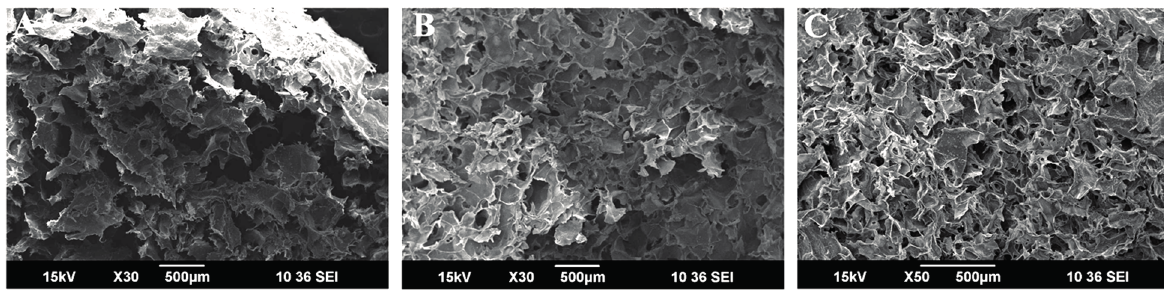
Figure 2. SEM image of different concentration of PBS in chitin/PBS ( A ) 10%, ( B ) 20%, and ( C )